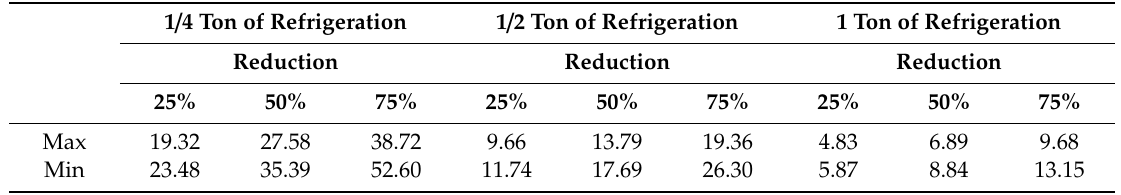
Table 3. Condensation times for each refrigeration package in seconds.